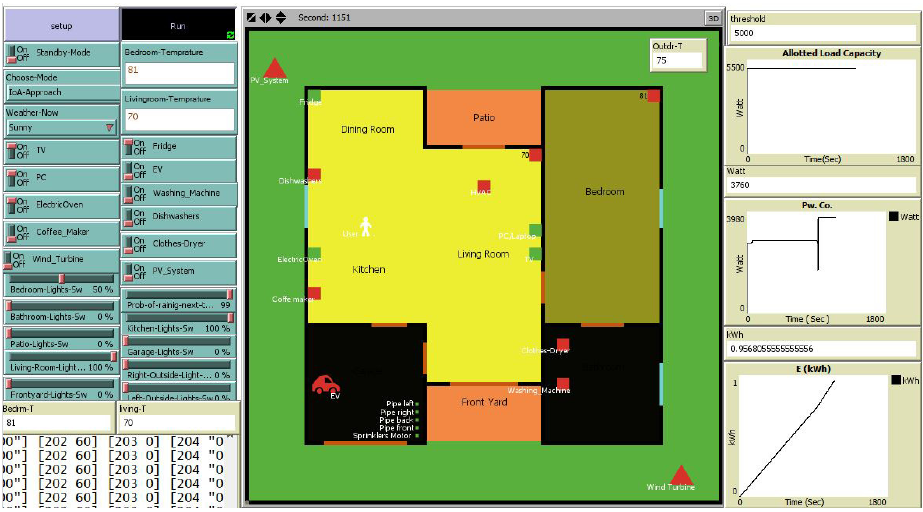
Figure 8. Simulated interface of smart HEMS.